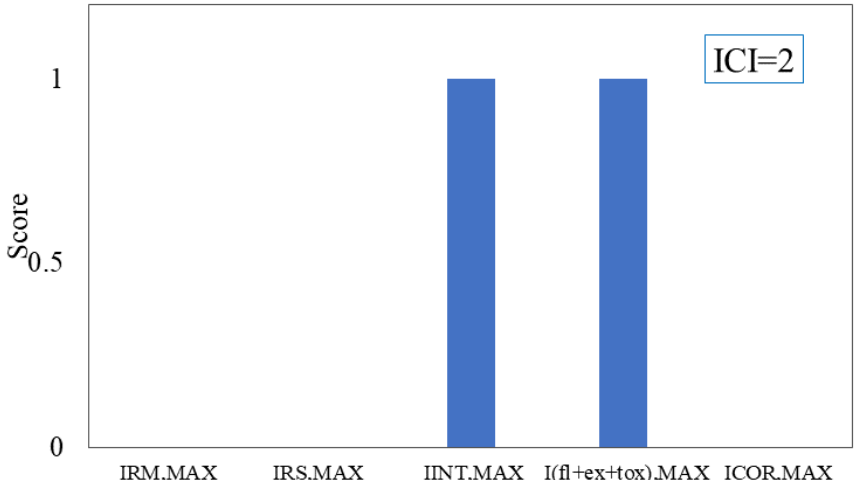
Figure 2. Calculated subindices for chemical inherent safety index and total score.